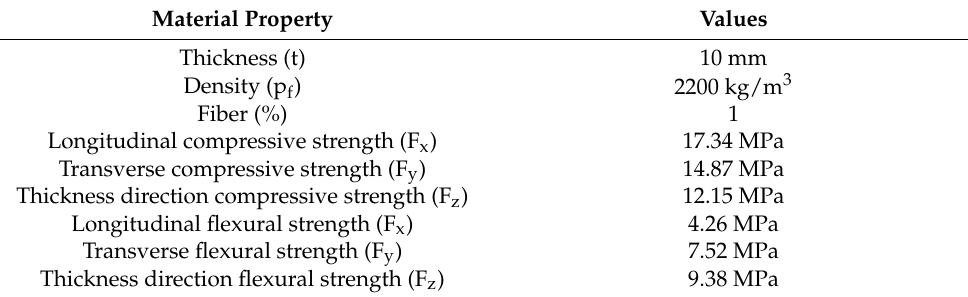
Table 1. Material parameters of fiber cement materials.